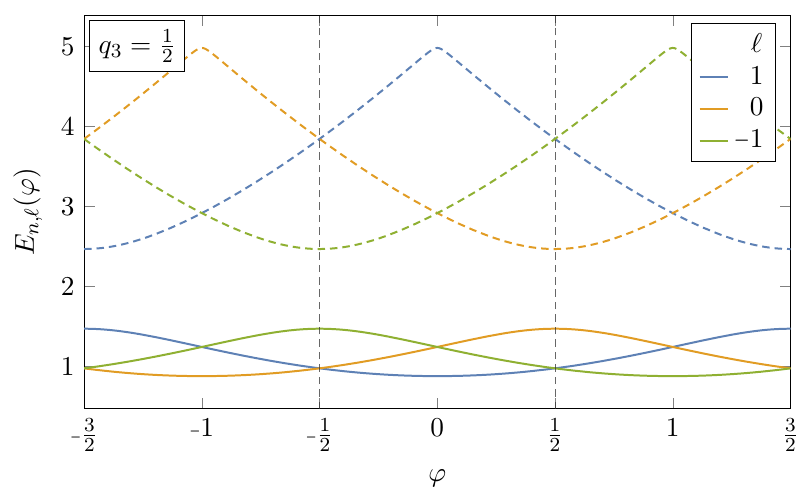
Figure 12. Energy eigenvalues, in units of (cid:25) 2 g 2 ~ 2 N 2 = 2, for the Hamiltonian (D.3) with N = 3 and q 3 = 1 = 2. We display three fundamental domains of ’ . In comparison with the model of section 2.3.2, each energy band now contains N states, labeled by ‘ , which permute among one another under (cid:20) (cid:20) + 1. We denote the states belonging to the n = 0 and n = 1 bands with solid ! and dashed lines,